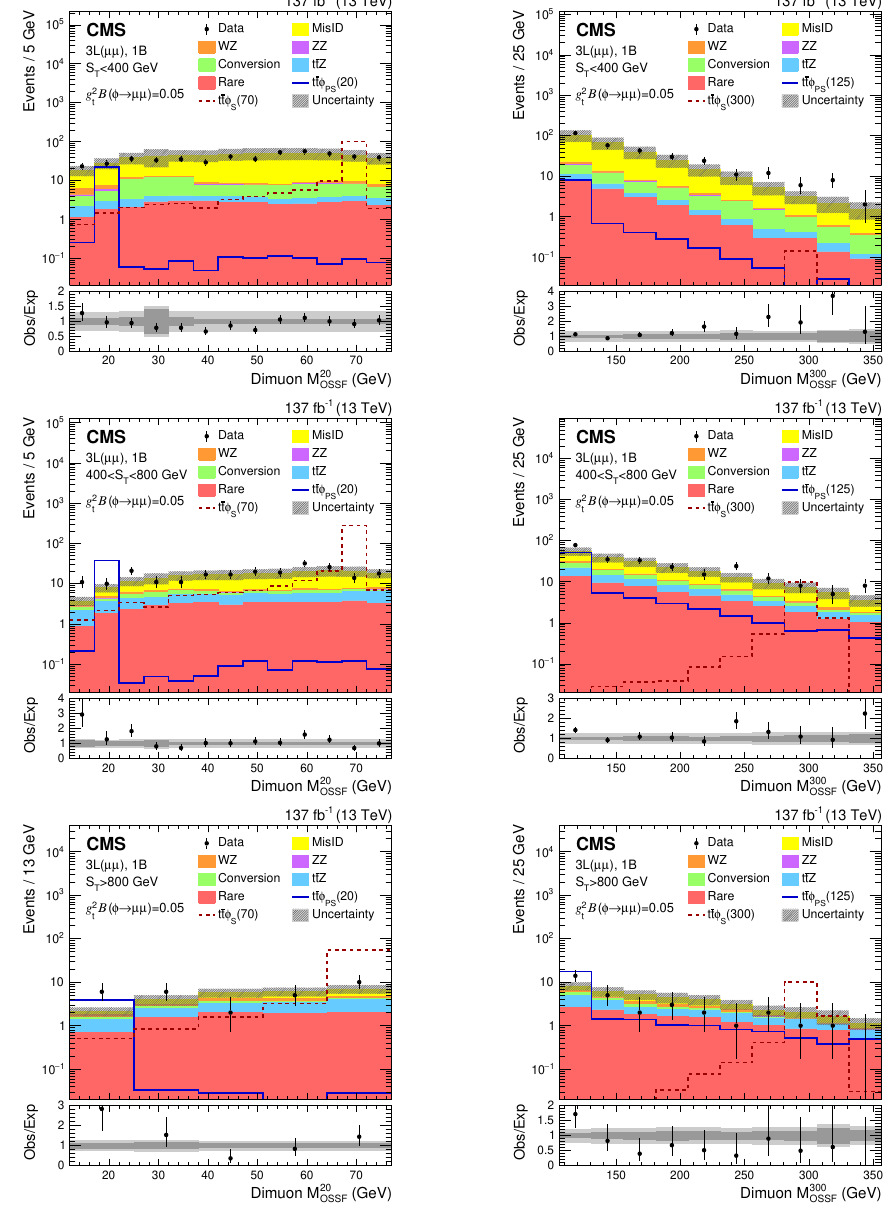
Figure 9 . Dimuon M 20 (left column) and M 300 (right column) distributions in the 3L( (cid:22)(cid:22) ) OSSF OSSF 1B tt (cid:30) signal regions. Upper, center, and lower plots are for S < 400 GeV, 400 < S < 800 GeV, T T and S > 800 GeV, respectively. The total SM background is shown as a stacked histogram of all T contributing processes. The predictions for tt (cid:30) ( ! (cid:22)(cid:22) ) models with a pseudoscalar (scalar) (cid:30) of 20 B ( (cid:30) ! (cid:22)(cid:22) ) = 0 : 05 are also shown. The lower panels and 125 (70 and 300) GeV mass assuming g 2 t show the ratio of observed to expected events. The hatched gray bands in the upper panels and the light gray bands in the lower panels represent the total (systematic and statistical) uncertainty of the backgrounds in each bin, whereas the dark gray bands in the lower panels represent only the statistical uncertainty of the backgrounds. The rightmost bins do not contain the over(cid:13)ow events as these are outside the probed mass range.